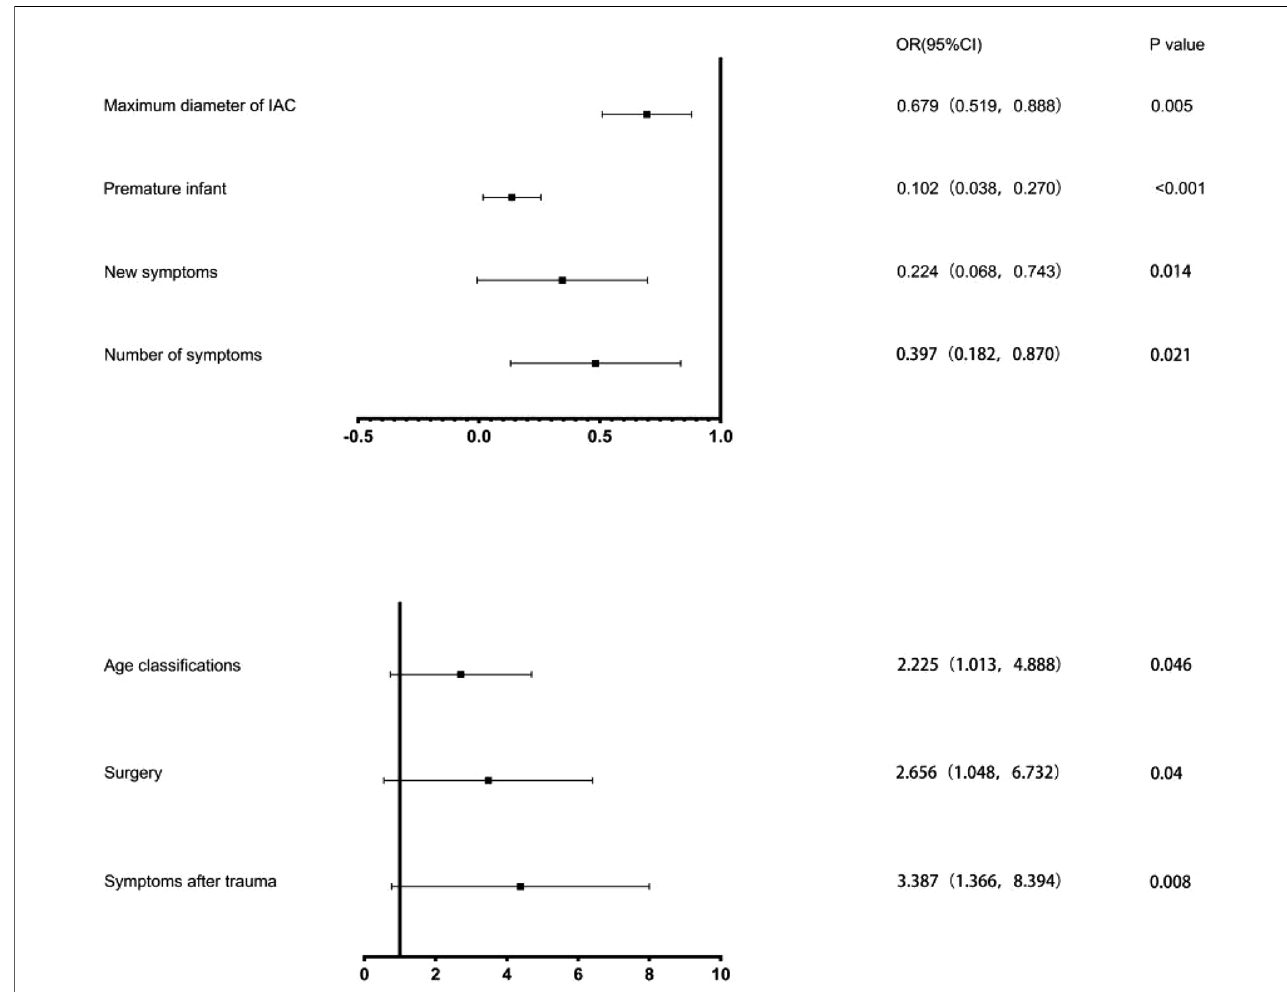
FIGURE 2 Results of Binary logistic regression analysis. The black squares indicate the OR values, the error bars represent 95% CIs, and P